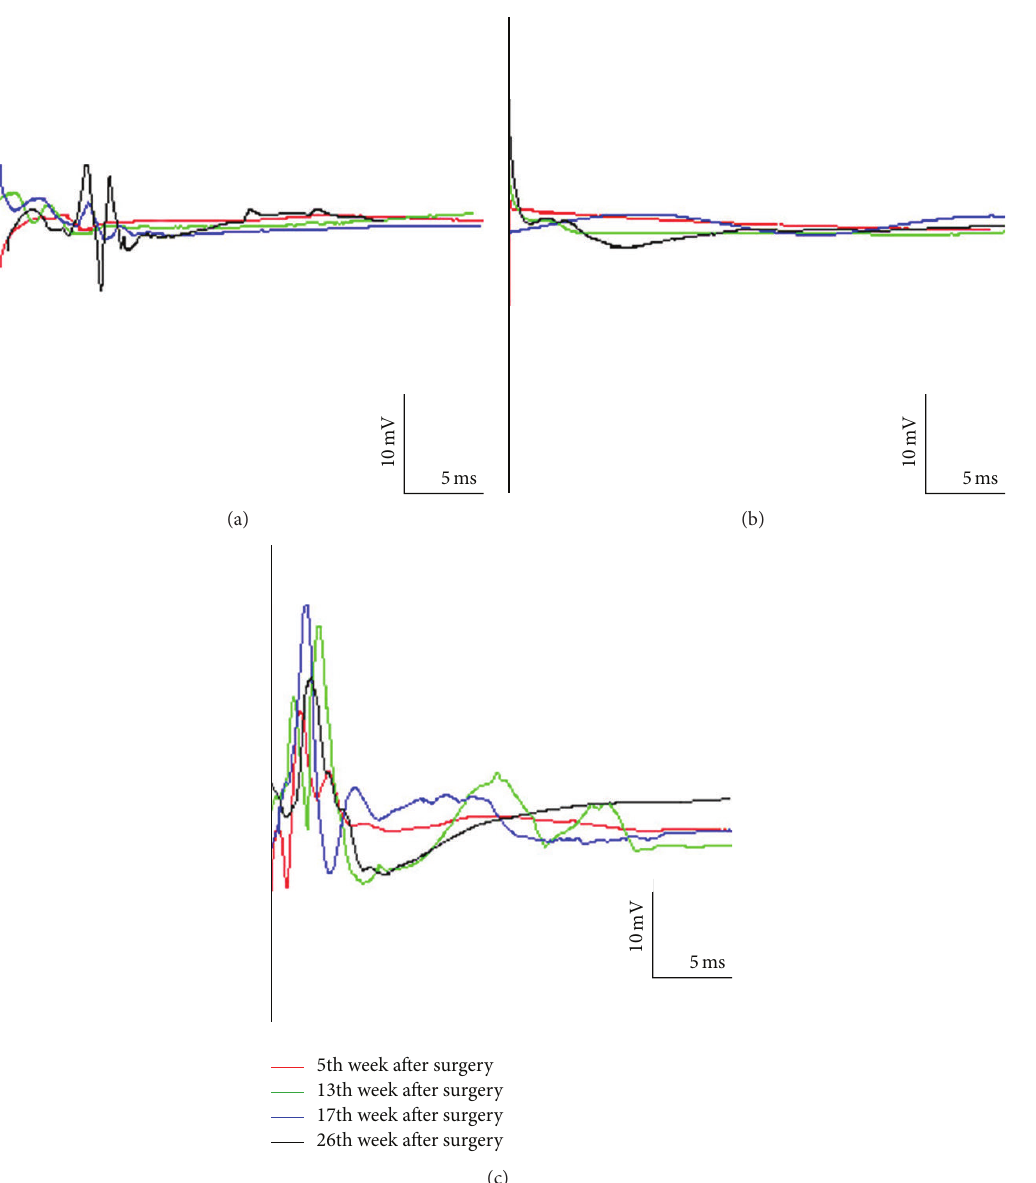
Figure 2: Electromyogram (EMG) of the quadriceps in the three groups. (a) Experimental group; (b) control group; (c) sham-operated group. The figure shows the compound muscle action potential (CMAP) amplitude at four time